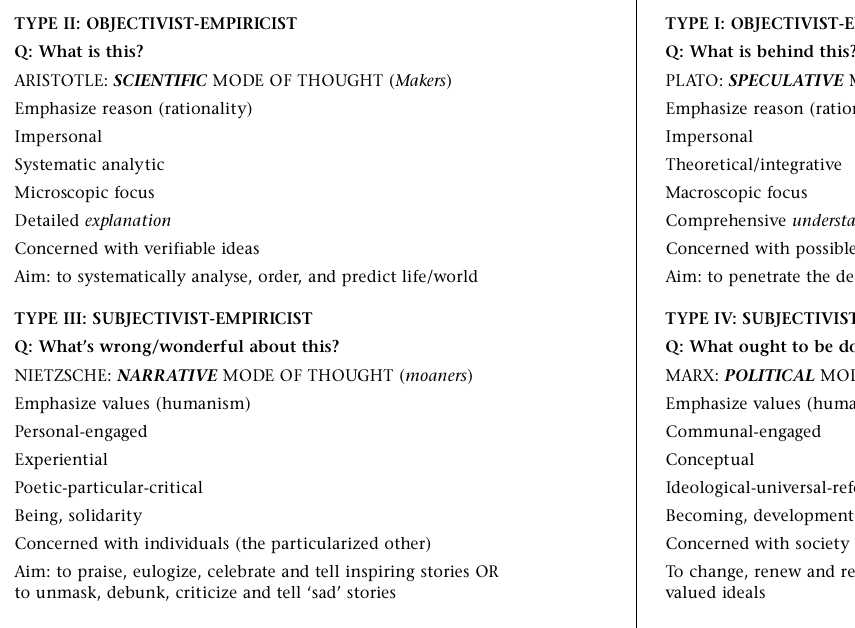
Figure 1: A meta-structure of knowledge (adapted from Pietersen,